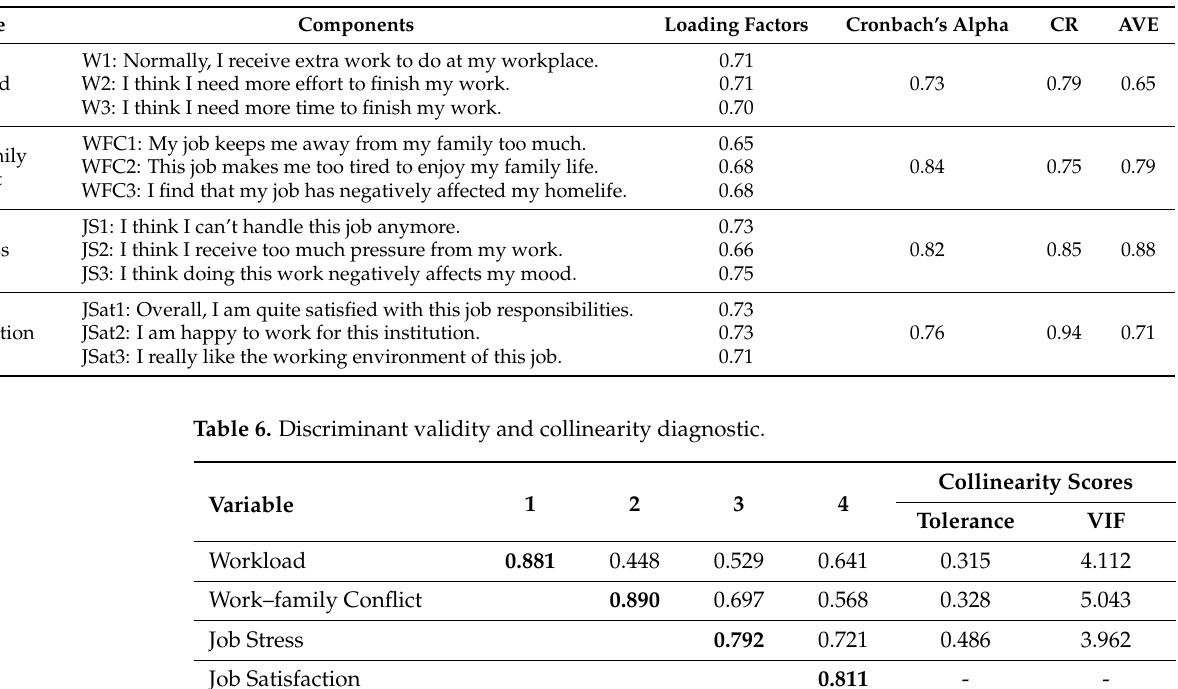
Table 5. Model measurement and convergent validity.